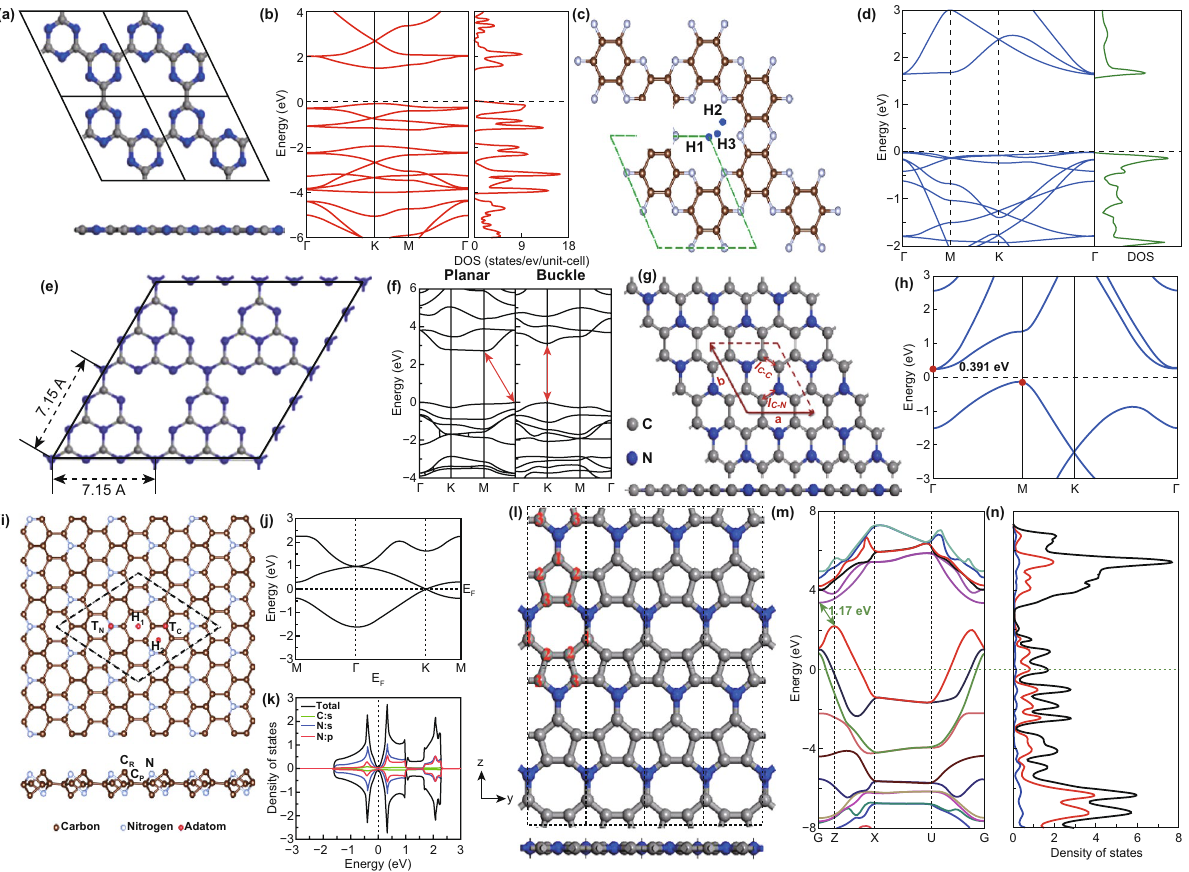
Fig. 4 a Top view and side view of the supercell (2 × 2) g-C 3 N 3 . b Band structure and total density of state for 1 × 1 g-C 3 N 3 . Reproduced with permission from Ref. [15]. c Relaxed structure of 2 × 2 C 2 N monolayer, H1, H2, and H3 are possible binding sites for transition metal atom doping on the C 2 N. d Band structure and density of states of C 2 N monolayer. Reproduced with permission from Ref. [28]. e Schematic structure of monolayer g-C 3 N 4 . Reproduced with permission from Ref. [18]. f Calculated band structures of monolayer g-C 3 N 4 with planar or buckled topology. Reproduced with permission from Ref. [20]. g Optimized structure and h band structure of C 3 N monolayer. The unit cell is shown by the red dashed line. Reproduced with permission from Ref. [29]. i Top and side view of the atomic structure of monolayer C 4 N. The black dashed lines show the 3 × 3 × 1 supercell of monolayer C 4 N. Four adsorption sites were considered (H 1 , H 2 , T C , T N ). j Electronic band structures and k PDOS of the unit cell of a pristine C 4 N monolayer. Reproduced with permission from Ref. [30]. l Top (upper) and side (lower) view of the atomic structure of C 5 N monolayer. The gray and blue balls represent C atoms and N atoms, respectively. m Band structure and n density of states (DOS) of C 5 N monolayer obtained from HSE06 calculations. The black, red, and blue lines denote the total DOS of C 5 N, the partial DOS of C atoms, and the partial DOS of N atoms, respectively. Reproduced with permission from Ref. [27]. Copyright permissions from Elsevier, Royal Society of Chemistry and Wiley–VCH. (Color figure